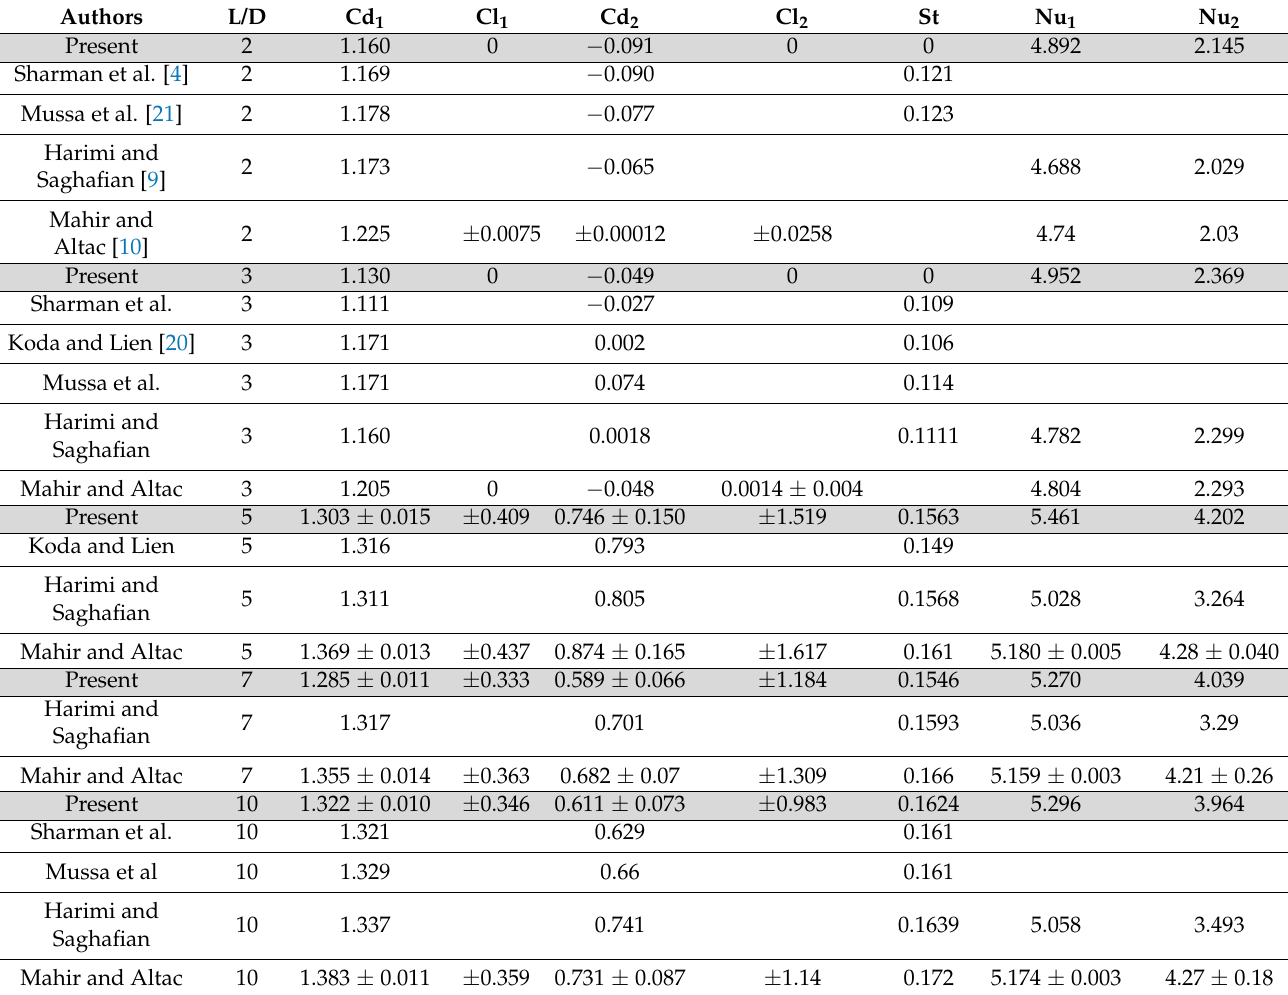
Table 1. Hydrodynamic forces coefficient and Nusselt number of a two-cylinder tandem array for flow at Re =